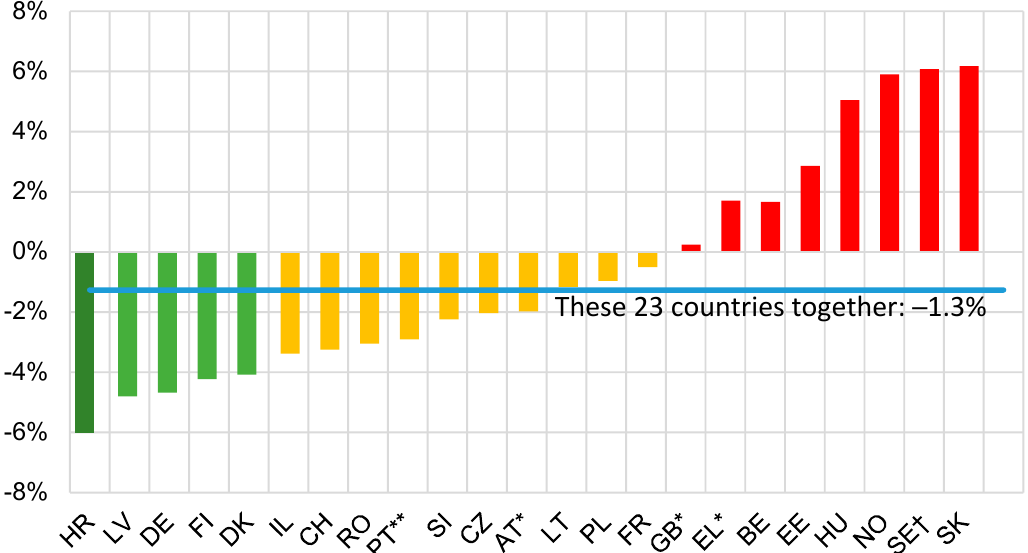
Figure 3. Reproduced with permission from the European Transport Safety Council. Di ff erence between the average annual percentage change in the number of drink-related road deaths and the corresponding change for other road deaths over the period 2010–2018 in 23 countries [18]. A negative di ff erence indicates faster reduction in drink-related deaths. * 2010–2017; ** 2010–2015; † driver deaths only; Key